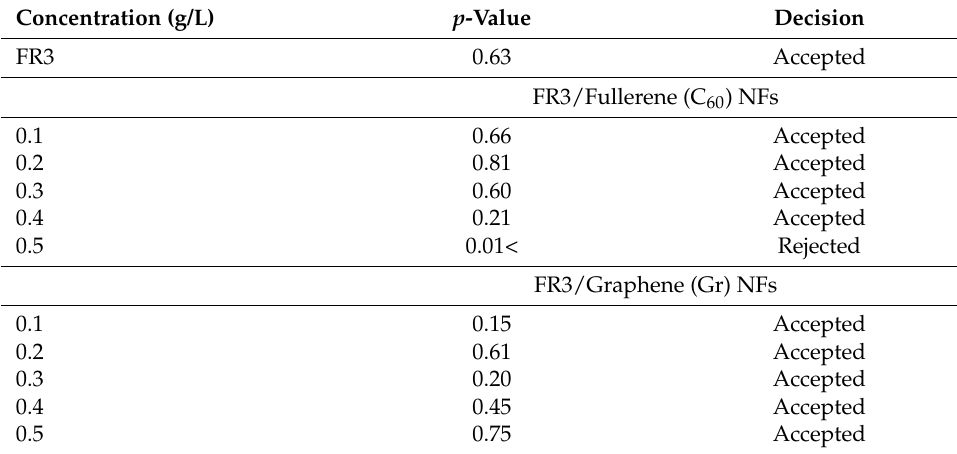
Table 5. AD goodness-of-fit test results.